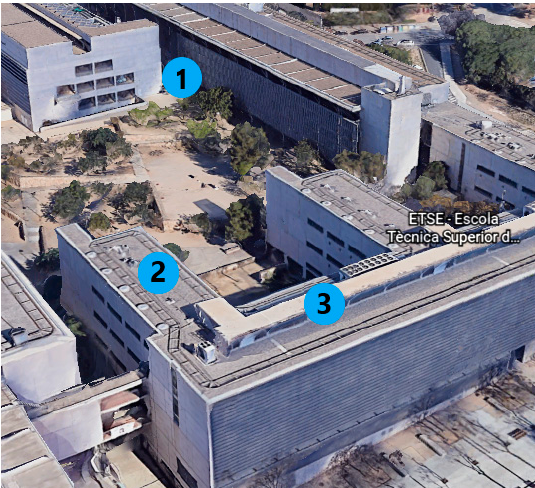
Figure 8. Location of the (1) gateway and (2–3) nodes in the second configuration. Gateway was placed at an office behind the metallic wall appearing in point 1 at ground level, while nodes were located at offices at points 2 (115 m from the gateway) and 3 (130 m from the gateway) in the third floor. Image taken from Google Earth.